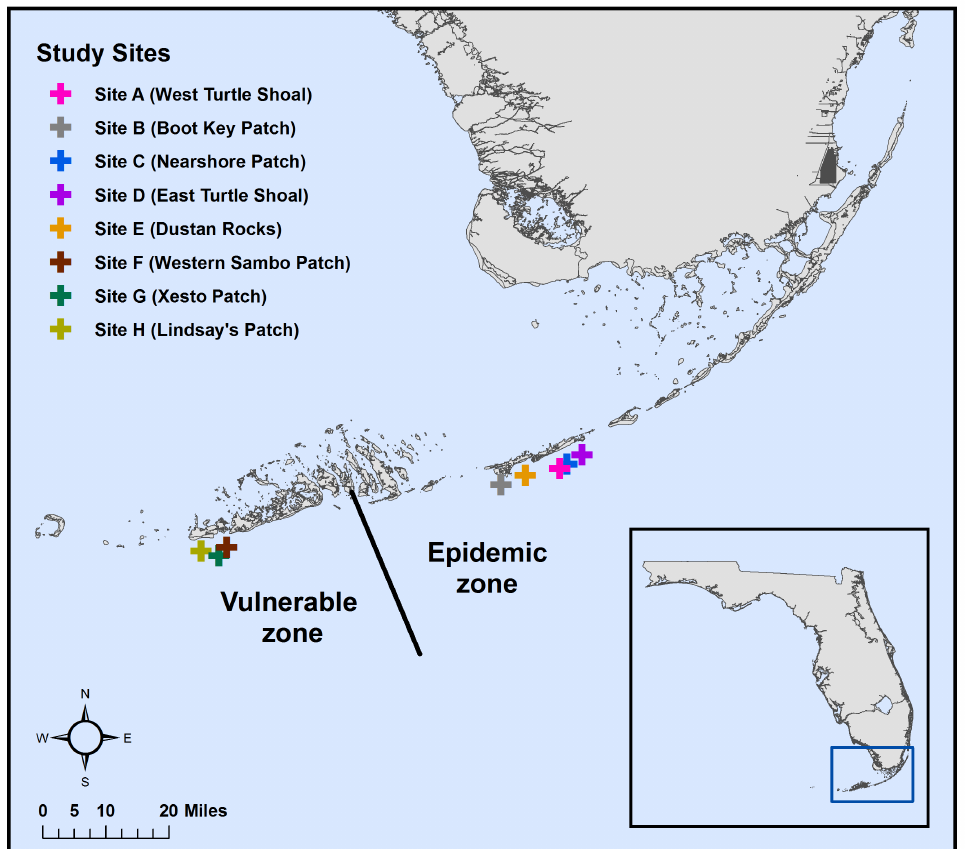
Figure 1. Map of sampling sites (n = 8; represented by symbols) along Florida’s Coral Reef (FCR). Five sites (Sites A–E) were located in the epidemic zone, an area of FCR where stony coral tissue loss disease (SCTLD) was active at the time. Three sites (Sites F–H) were located ahead of the epidemic zone in an area designated the vulnerable zone. The black line indicates the approximate front of SCTLD at the time of sampling in 2018. Coral reef names corresponding to Sites A–H are in